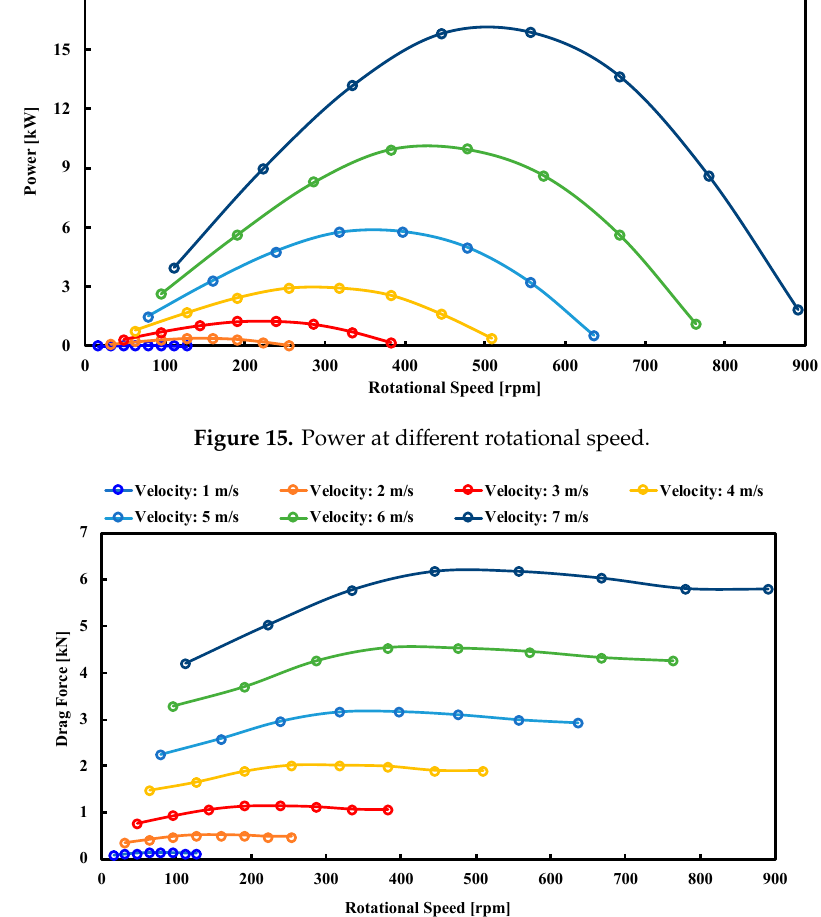
Figure 16. Drag force at different rotational speed.